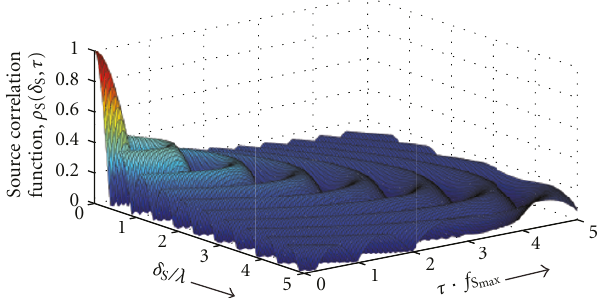
Figure 3: The source CF ρ S ( δ S , τ ) of the 2 × 2 × 2 MIMO M2M reference channel model under isotropic scattering conditions.